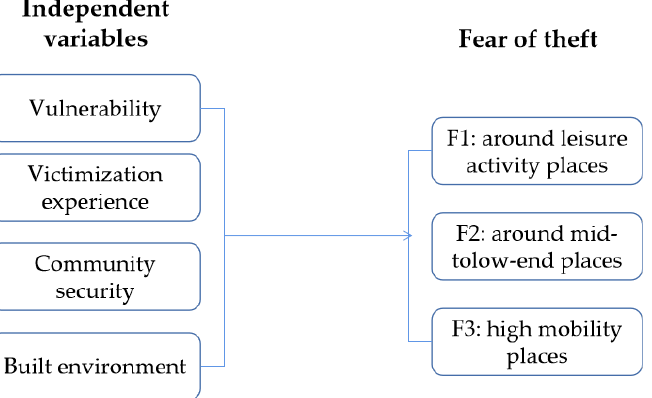
Figure 2. The conceptual framework of the relationship among independent variables and fear of theft around different